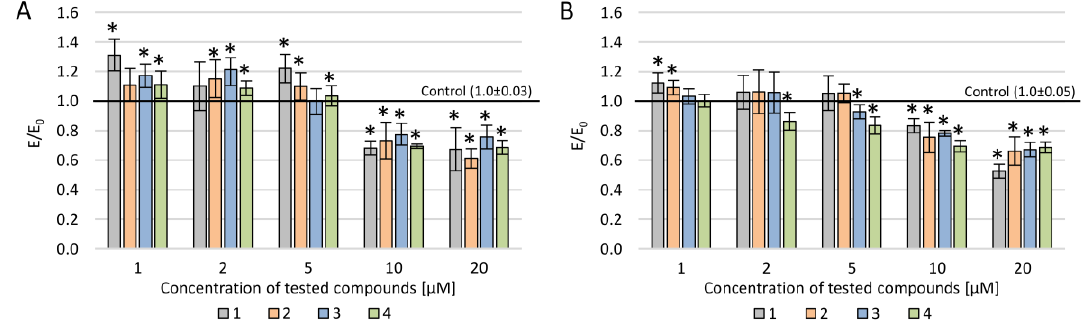
Figure 4. DCF-DA assay — DCF (2′,7′ -dichlorofluorescein) concentration after incubation with new olivacine derivatives in various concentration ranges: ( A ) LoVo cells, ( B ) LoVo/DX cells; * p < 0.05 — significant difference compared to control.